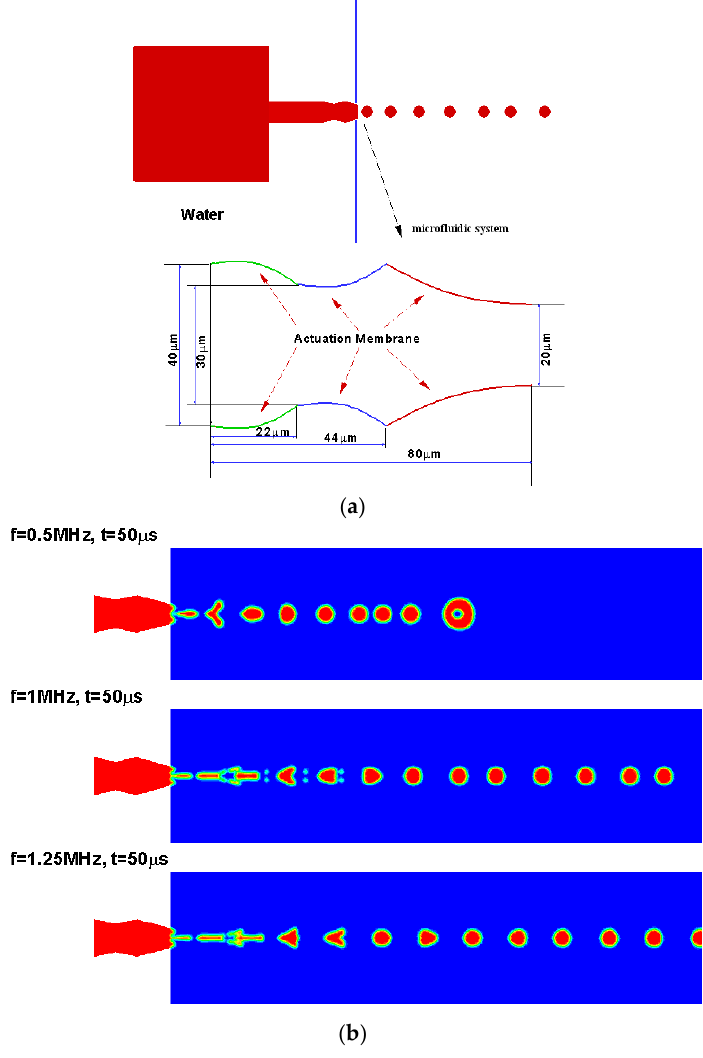
Figure 6. ( a ) Design concept for droplet generation using moving walls; ( b ) design simulations from a novel droplet generator. Reproduced from reference [20], with the permission of AIP Publishing.